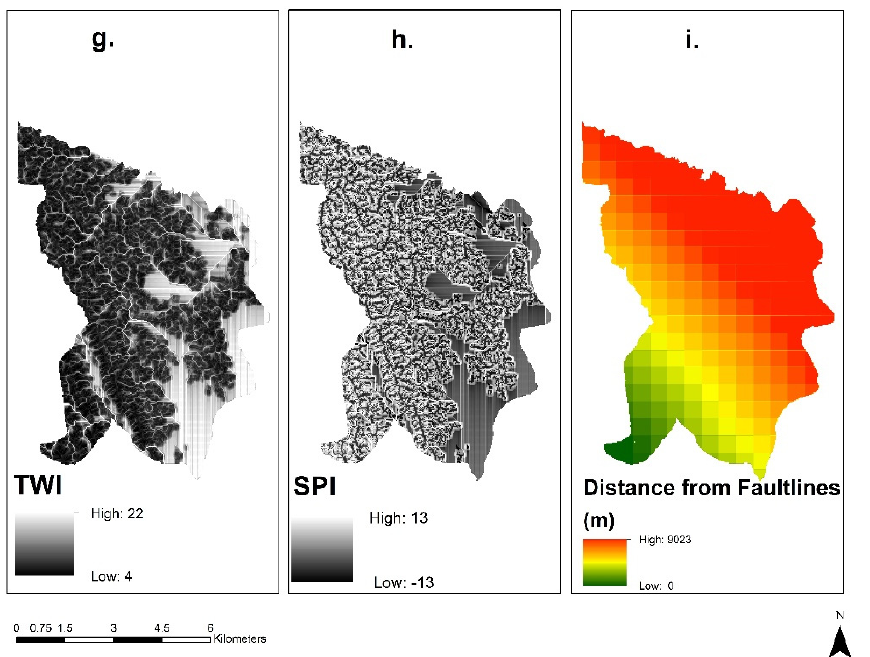
Figure 2. Relatively stable causal factors: ( a ) elevation, ( b ) slope, ( c ) aspect, ( d ) plan curvature, ( e ) profile curvature, ( f ) distance from the drainage network, ( g ) TWI, ( h ) SPI, ( i ) distance from fault lines.